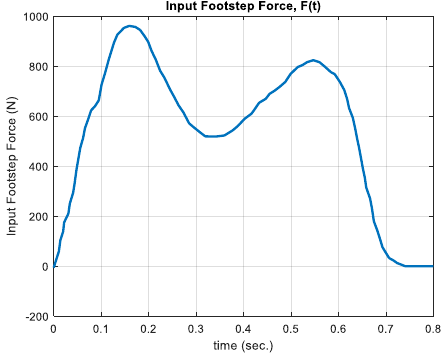
Figure 4. Input Footstep Force.